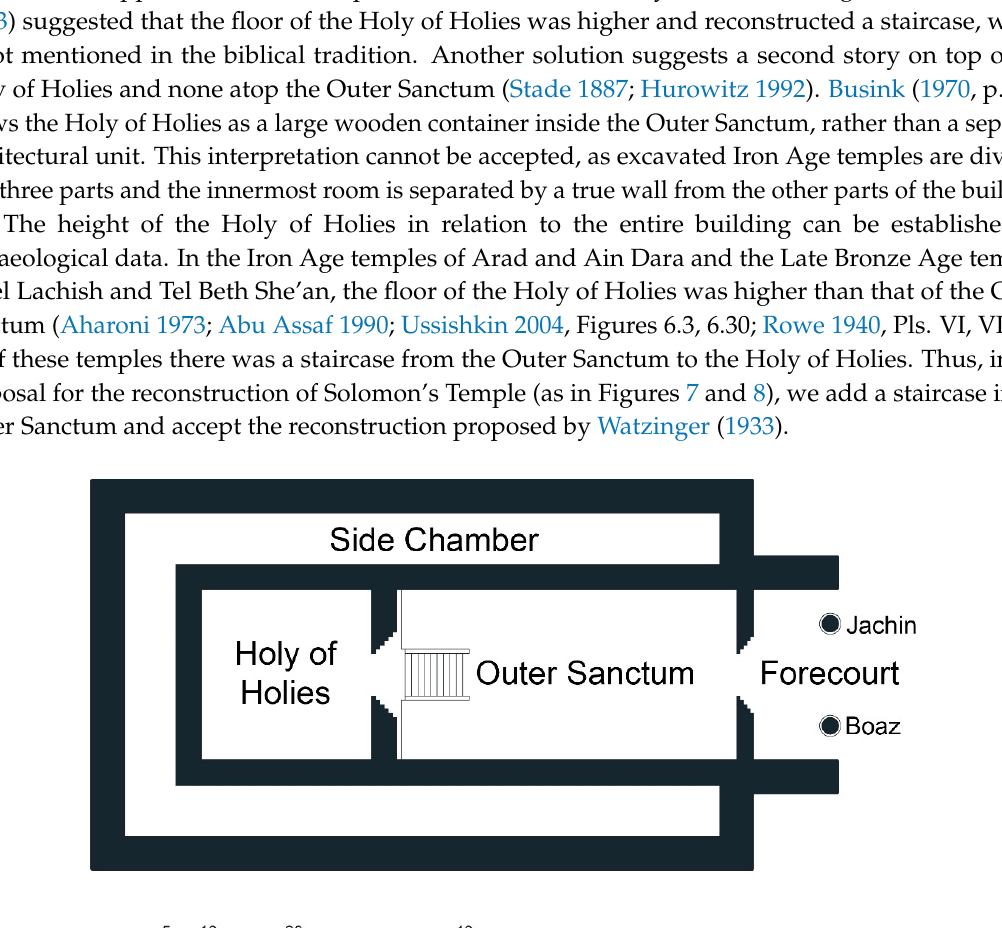
Figure 7. Ground plan of Solomon’s Temple based on our analysis of the text and relevant archaeological data.